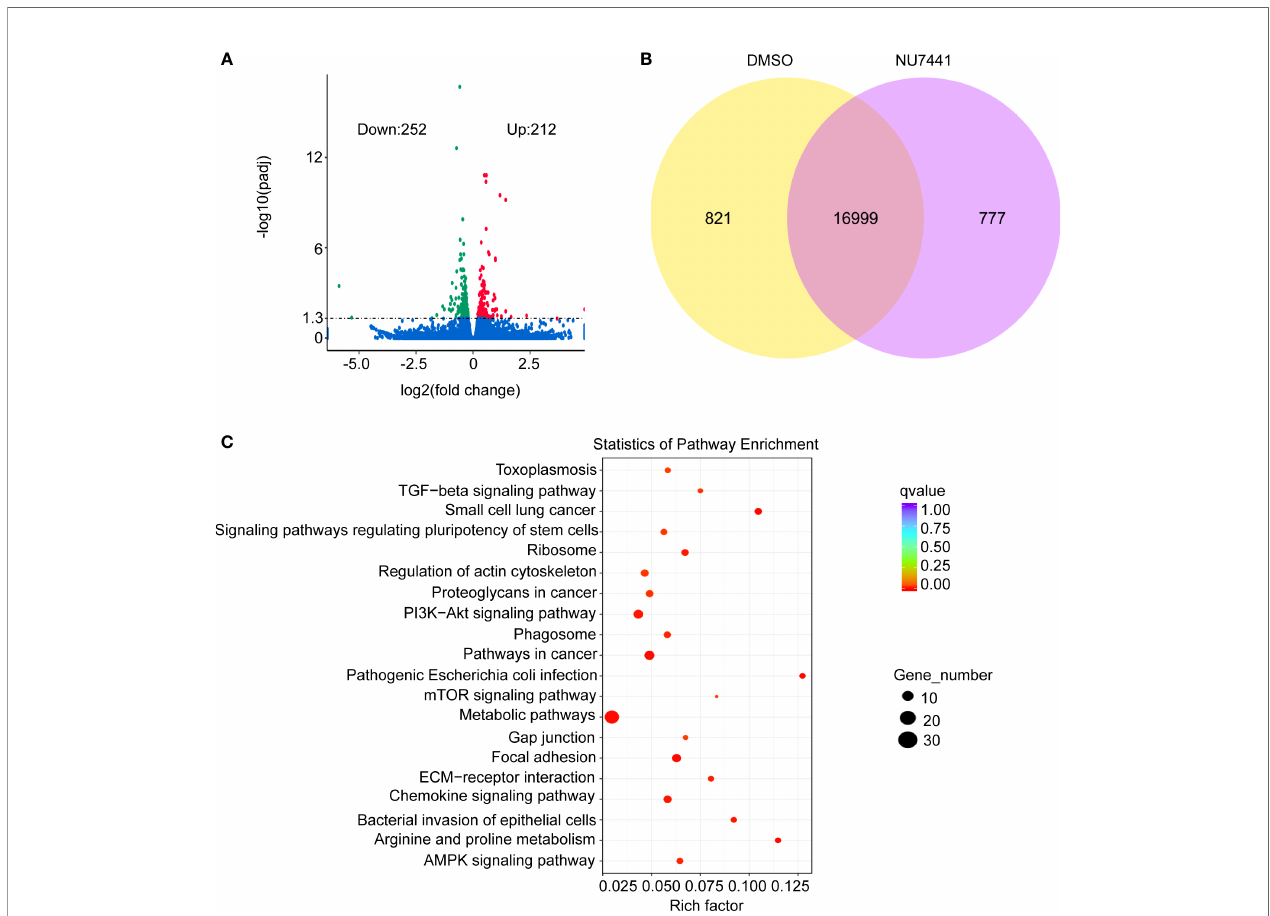
FIGURE 4 | Differential expression of genes analysis in the short-read data. (A) Volcano plot for differentially expressed genes between control and NU7441-treated cells. (B) Venn diagram for differentially or co-expressed genes between control and NU7441-treated cells. (C) Functional enrichment of the differentially expressed genes between control and NU7441-treated